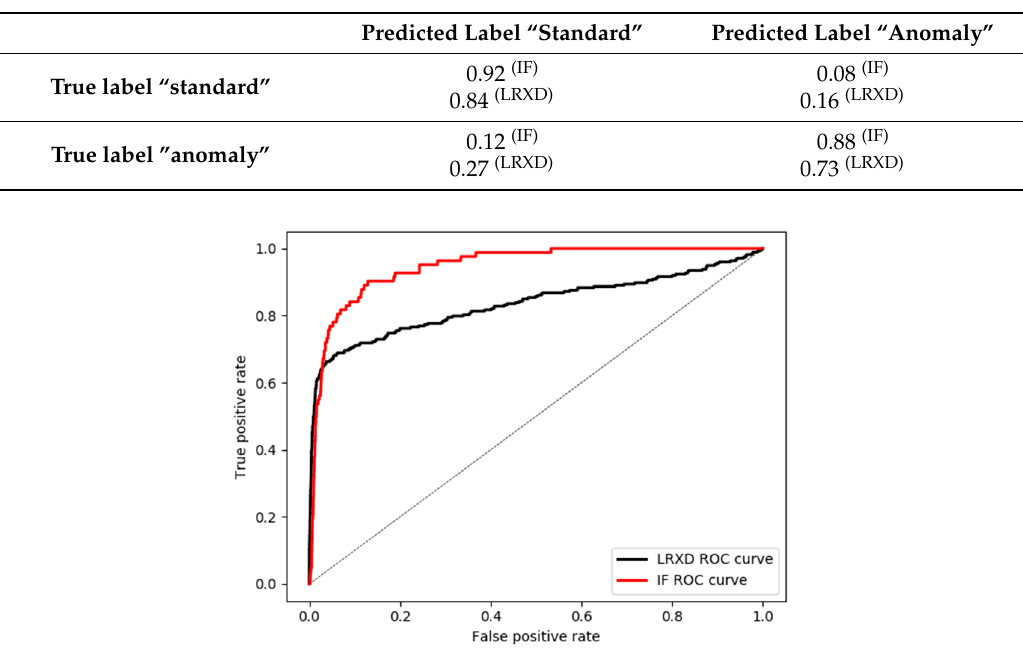
Figure 8. Receiver operating characteristic (ROC) curves for Isolation Forest (IF) and local Reed–Xiaoli detector (LRXD) anomaly detection calculated for the submerged structures.